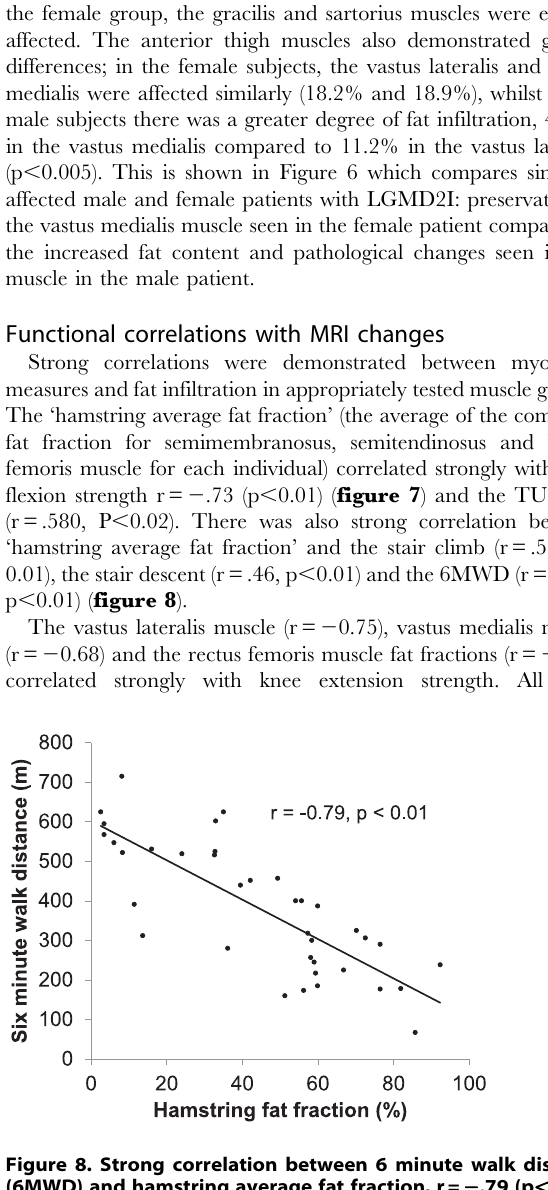
Figure 6. Comparison of the thigh muscles in (a) a male LGMD2I patient with more advanced pathology and increased fat content seen in the vastus medialis muscle (72.2%) and (b) preservation of the vastus medialis muscle (9.7%) of a female LGMD2I patient. (VM= vastus medialis, VL= vastus lateralis).